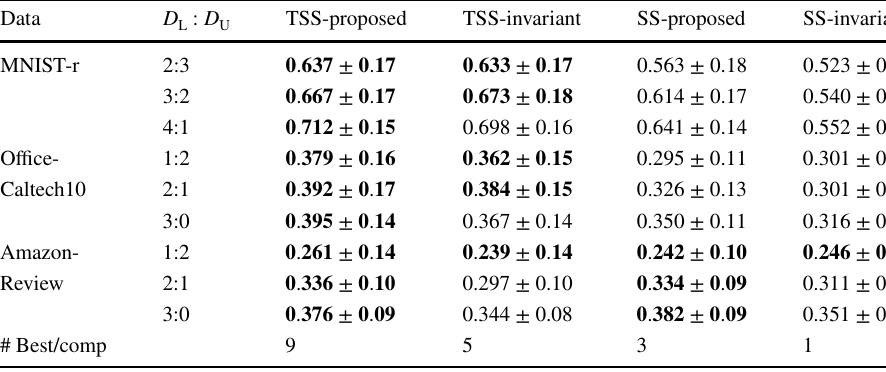
The ‘T’ denotes using target unlabeled data for training. Table interpretation is the same as Table 1 Boldface denotes the best and comparable methods according to the paired t test at the significance